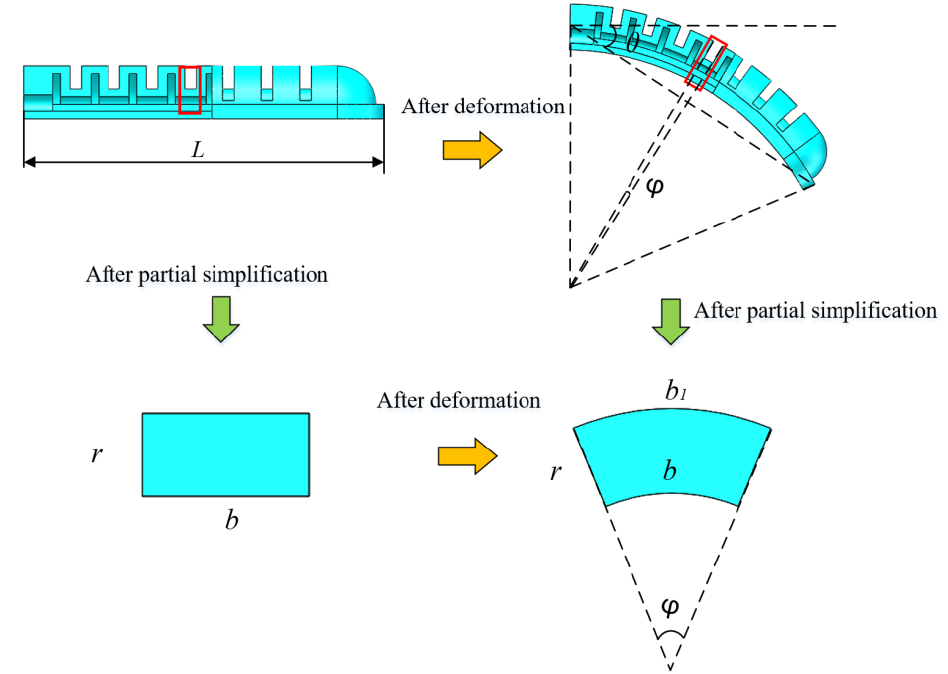
Figure 8. Simplified schematic diagram of cavity structure deformation .